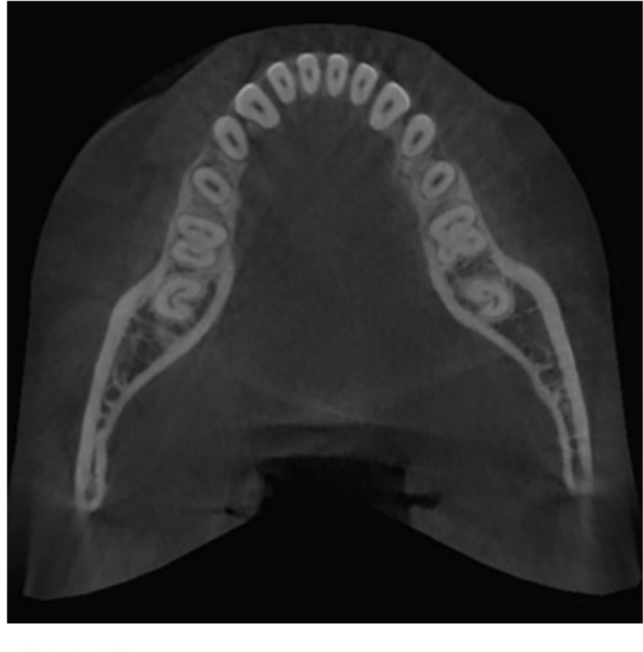
Fig. 4a - CBCT axial view - bilateral occurrence of C - shaped canals in teeth no. 37 (C2), 47 (C1), unilateral presence of radix entomolaris in tooth no. 36.